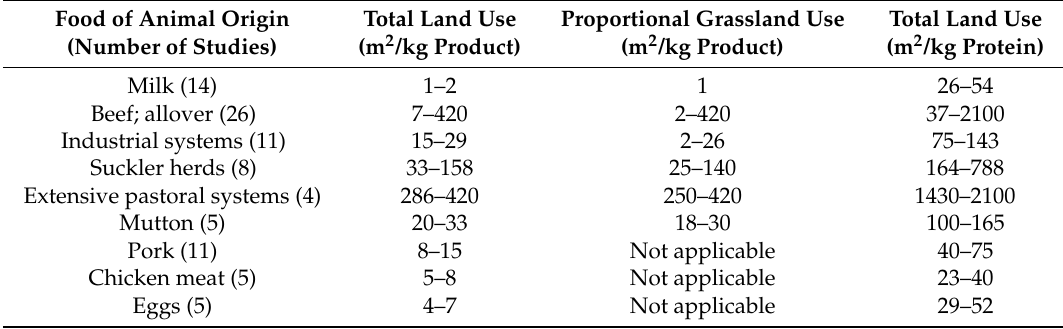
Table 8. Land use (both total and grassland) per kg product and per kg edible protein [38].